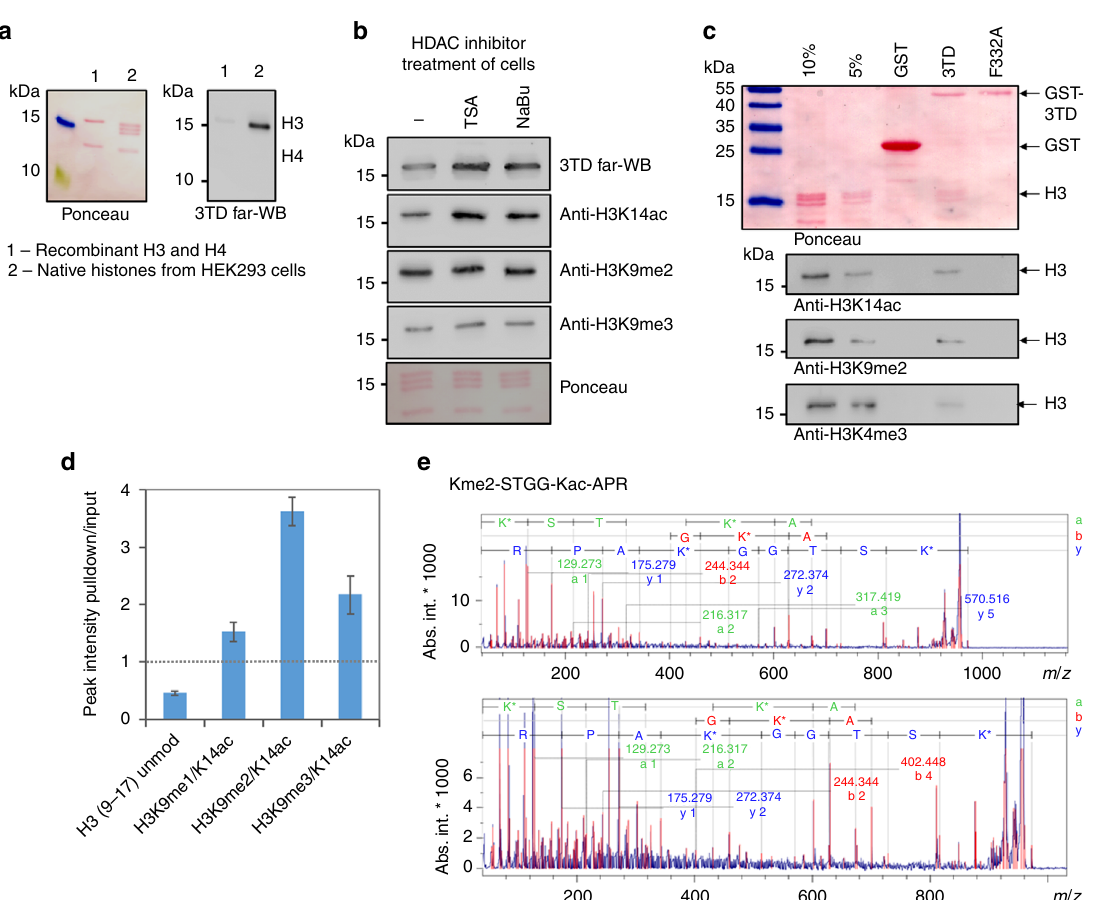
Fig. 5 Binding of 3TD to modi fi ed H3 and nucleosomes. a Far-western blot analysis of 3TD binding to recombinant histones H3 and H4 (lane 1) and native histones (lane 2). Positions of the H3 and H4 proteins are indicated. The Ponceau-stained membrane is shown as a loading control. b Far-western blot analysis of 3TD binding to native histones isolated from HEK293 cells after treatment with histone deacetylase inhibitors trichostatin A (TSA) or sodium butyrate (NaBu). Untreated ( − ) cells are used as a control. The abundance of histone PTMs in the histone preparations was analyzed by western blot. The Ponceau-stained membrane is shown as a loading control. c Western blot analysis of the GST-3TD wildtype and F332A mutant mononucleosomal pull- down. Mononucleosomes were isolated from HEK293 cells. GST was used as a negative control. d MALDI MS analysis of the 3TD mononucleosomal pull- down. Quanti fi cation of the MS data (Supplementary Fig. 8) shows an enrichment of the H3K9me/K14ac peptides in 3TD pull-down and depletion of the unmodi fi ed H3(9 – 17) peptide when compared to input. Internal normalization was done using peaks of unrelated, unmodi fi ed H3 peptides. The error bars represent the SEM of two biological repeats. MS/MS for H3(9 – 17) and H3(41 – 49) are shown in Supplementary Fig. 8c,d. e MS/MS analysis of the H3 (9 – 17) Kme2-STGG-Kac-APR peptide fragment (theoretical mass MH + : 971.563 Da: experimental mass: 971.482Da). Fragment ions of the a, b, and y series are indicated in green, red, and blue, respectively. The two panels show the same analysis with different x - and y -axis